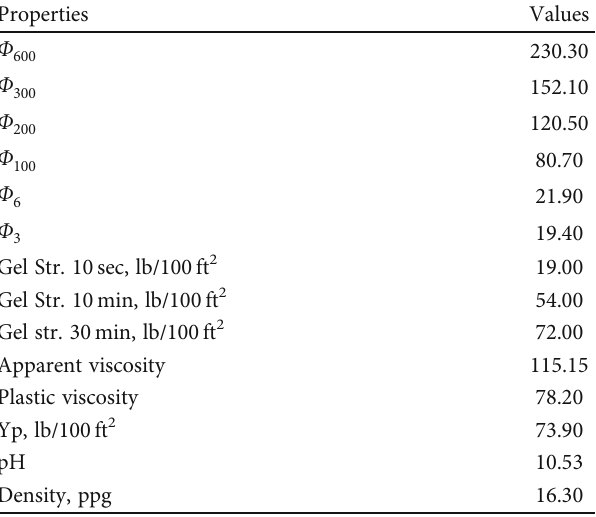
Table 2: Drilling fl uid properties at 120 ° F and atmospheric